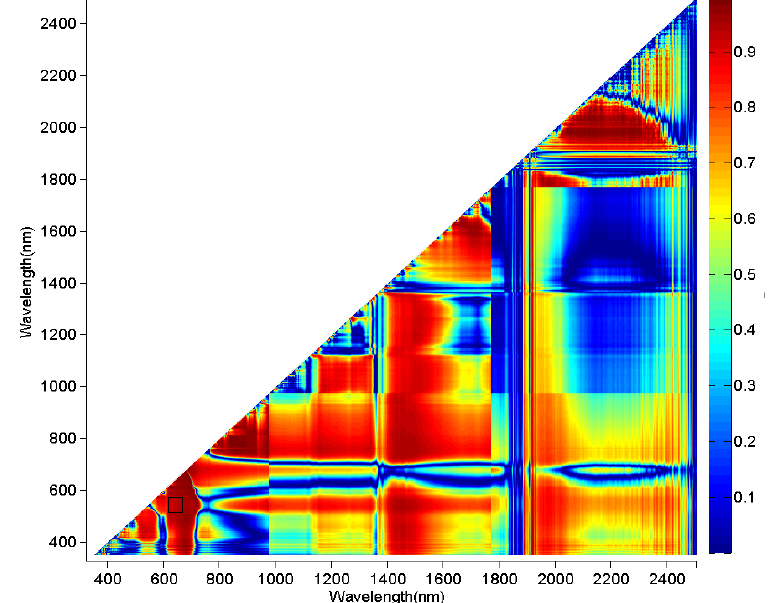
Figure 7. 2D correlation plots illustrating the coefficient of determination (R 2 ) of linear regression between all possible Two-Band Vegetation Index (TBVI) and cone densities. The black square frame is the region of Green and Red corresponding to MODIS Bands 4 and